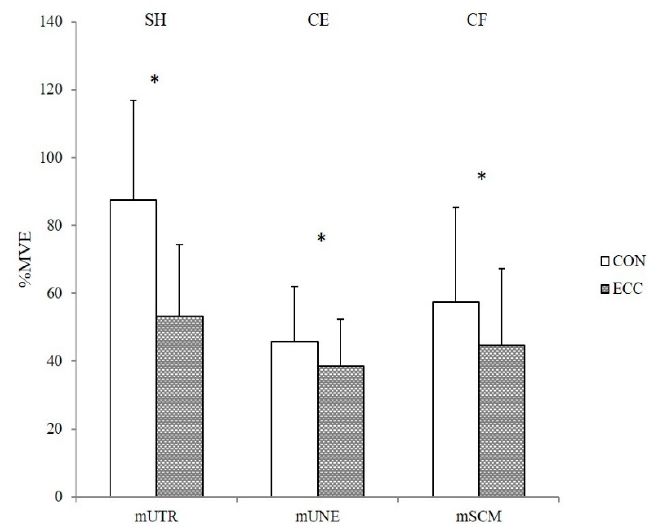
Figure 4. The muscle activity (%MVE) of the upper trapezius muscle (mUTR), upper neck extensors muscles (mUNE), and sternocleidomastoideus muscles (mSCM) in the concentric phase (CON) and eccentric phase (ECC) during shugs (SH), cervical extension (CE), and cervical flexion (CF), respectively. * Indicates significant difference between CON and ECC within exercise.